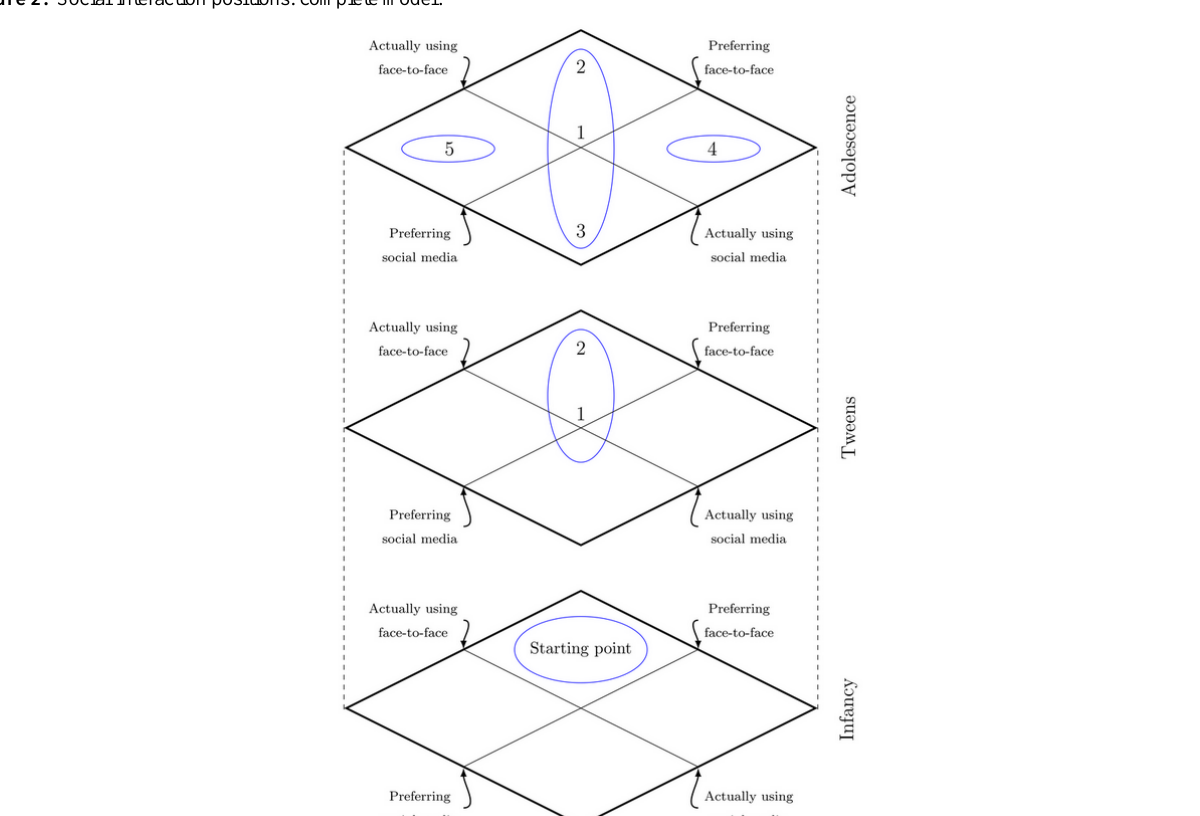
Figure 2. Social interaction positions: complete